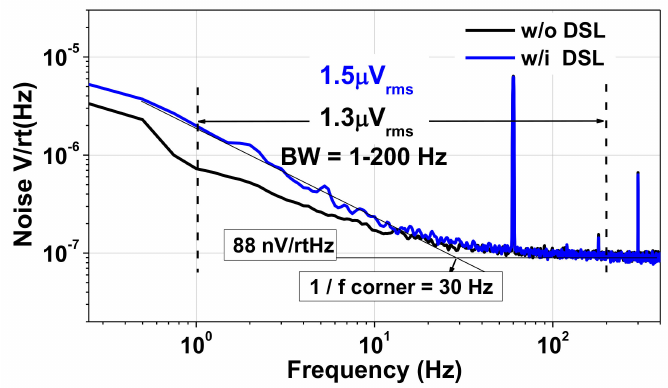
Figure 15. Measured input-referred noise voltage spectral density.